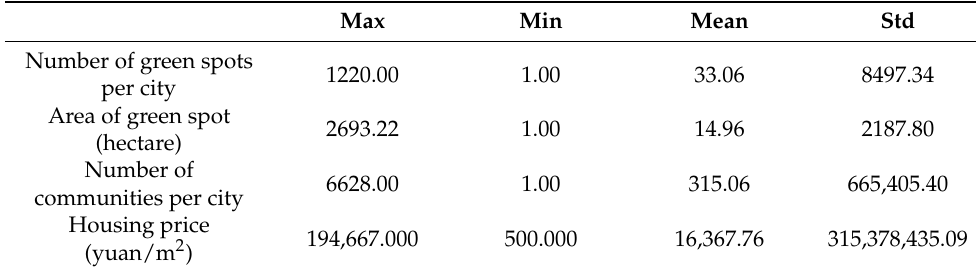
Table 2. Basic data on green space and communities in 254